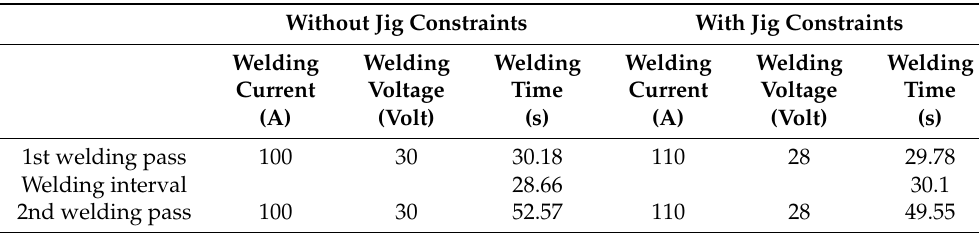
Table 1. Welding parameters for the test workpiece.